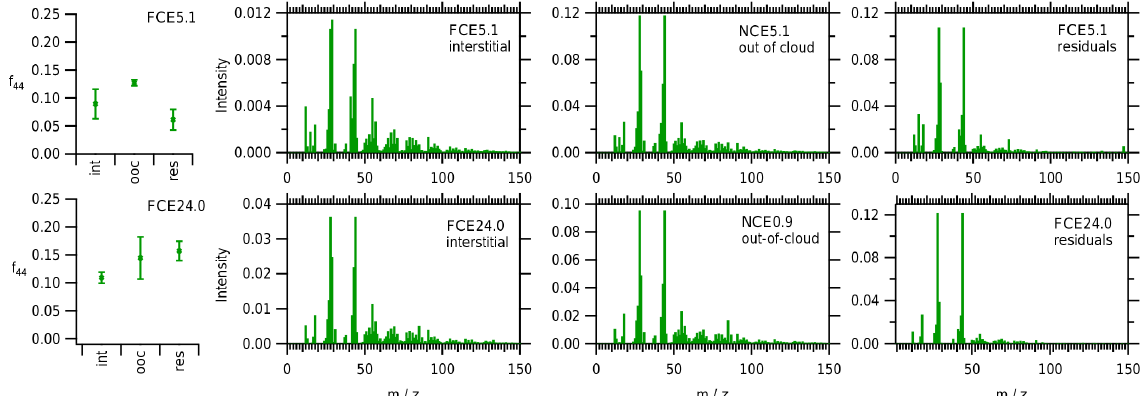
Figure 10. f 44 values (with standard deviations) and organic mass spectra for interstitial aerosol, out-of-cloud aerosol, and cloud residuals, for two selected cloud events with low and high temperature (upper row panels: FCE5.1, 6.9 ◦ C; lower row panels: FCE24.0, − 3.0 ◦ C) and the best match between cloud and out-of-cloud trajectories (Table 1). Note that the f 44 values measured with the C-ToF-AMS have been scaled to the HR-ToF-AMS as described in Sect. 2.4 and Fig. S3, but the mass spectra are plotted as